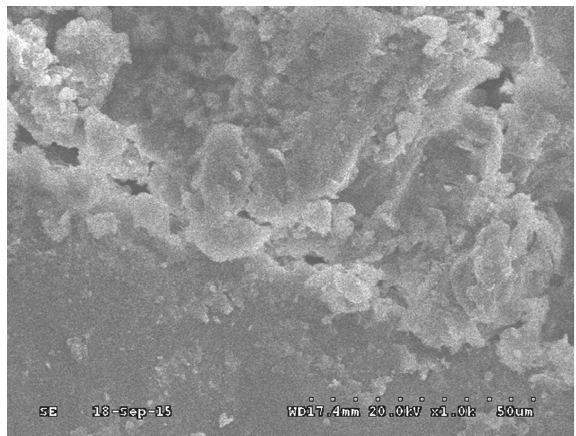
Figure 3: Microstructural feature of Pb-5000 mg/kg contaminated soils stabilized by 15% cement under 0 freeze-thaw cycle.